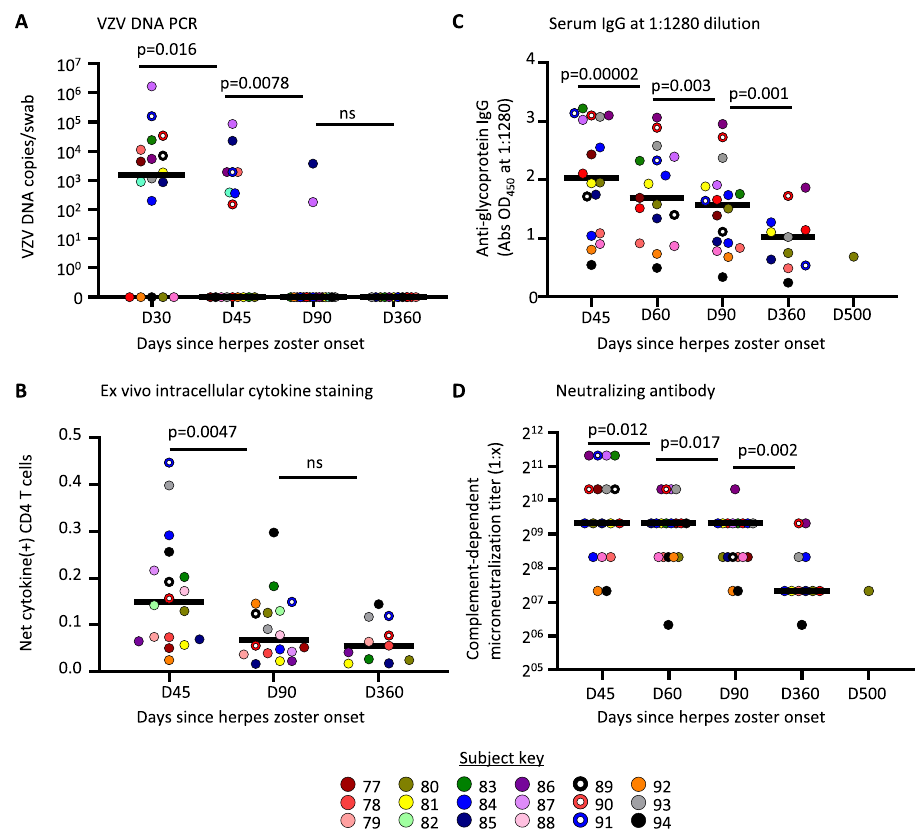
Fig. 1 | Varicella-zoster virus (VZV) clearance and systemic immunity after herpes zoster (HZ). A VZV DNA copy number was determined by polymerase chain reaction (PCR) from swabs taken from the HZ rash site at the indicated time frames(D=day) afterHZonset. B Net frequencyof CD4TcellsinPBMC withVZV- speci fi c interferon- γ (IFN- γ ) and/or interleukin 2 (IL-2) responses. C Serum IgG responses to mixed VZV glycoproteins measured by ELISA at a serum dilution of 1:1280. D Complement-dependent VZVmicroneutralizationtiterof seraover